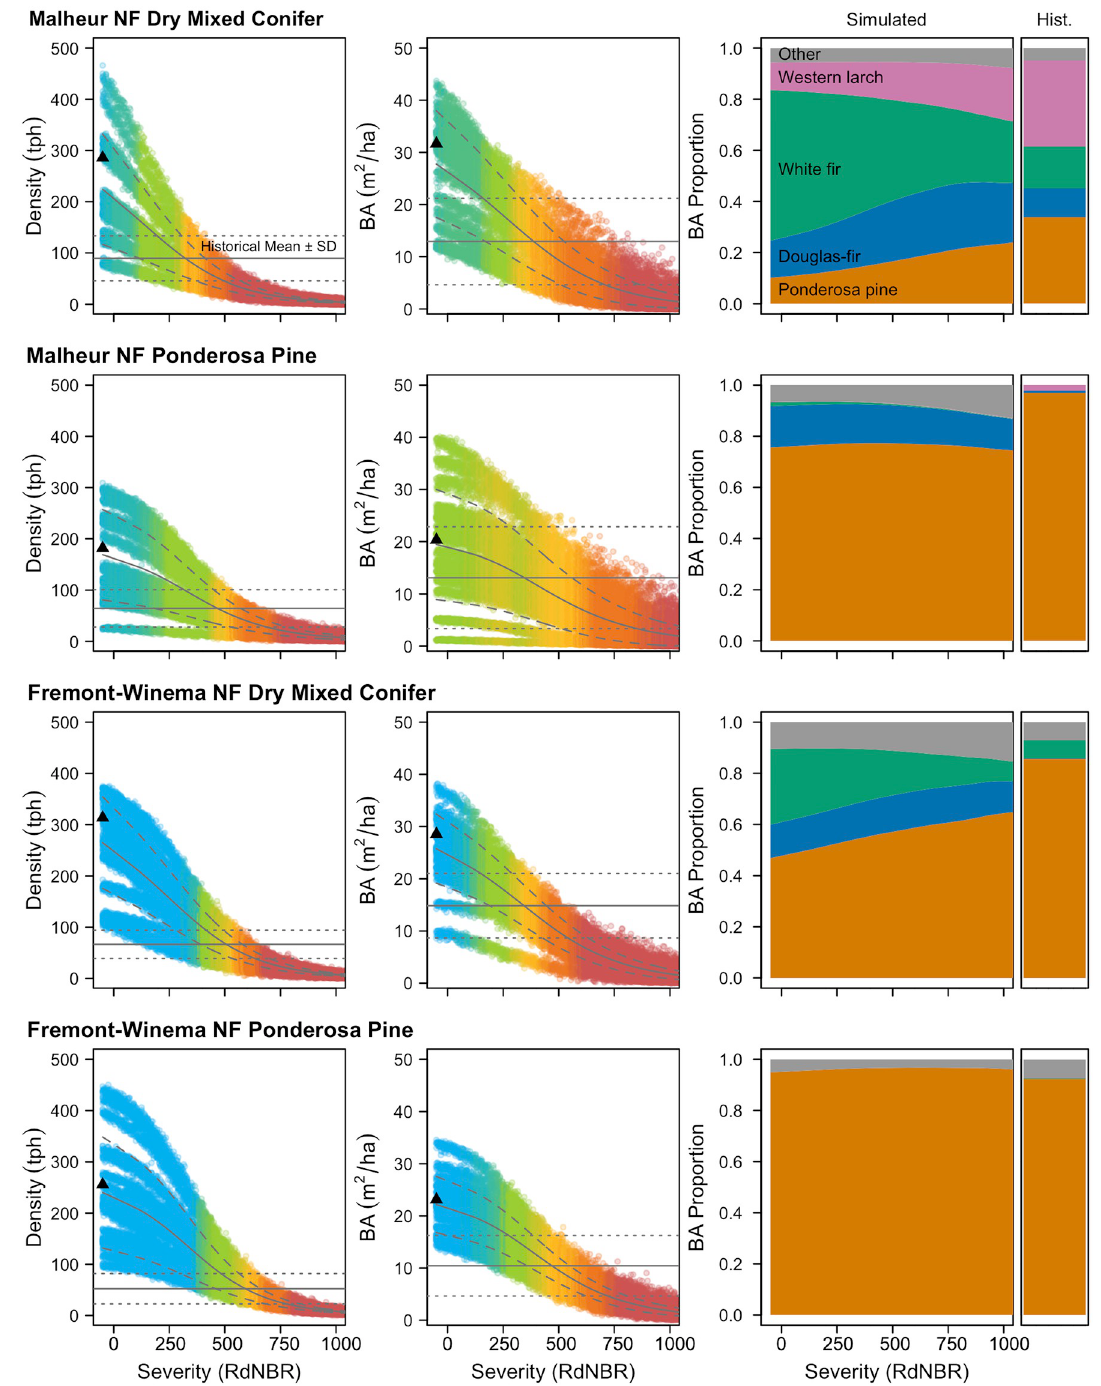
Fig 4. Density, basal area, and species composition of simulated dry mixed conifer and ponderosa pine stands in the Malheur and Fremont-Winema National Forests across a fire severity gradient from -50 to 1,000 RdNBR for trees � 15cm. Mortality of individual trees within 17–18 stands was estimated 5 times across the fire severity gradient (in 5-unit steps) and stand density or basal area from each iterated stand are displayed as points. Points are colored according to the proportion that fall within the historical range of variation (mean ± 1SD, displayed as horizontal lines on each graph) reported for each forest type within each national forest with yellow representing the highest proportion of simulations that fell within the range. The loess smoothed mean ± 1SD of all simulations is displayed as an entire and dashed line within the simulated points. Triangles along the X-axis display unburned stand density and basal area. Basal area proportion is a loess smoothed average of all simulated stands for which total basal area was > 0. Historical proportions are average basal area composition reported for the respective historical reconstructions. See Fig 4 in S1 Appendix for graphs for the Deschutes and Ochoco National Forest.